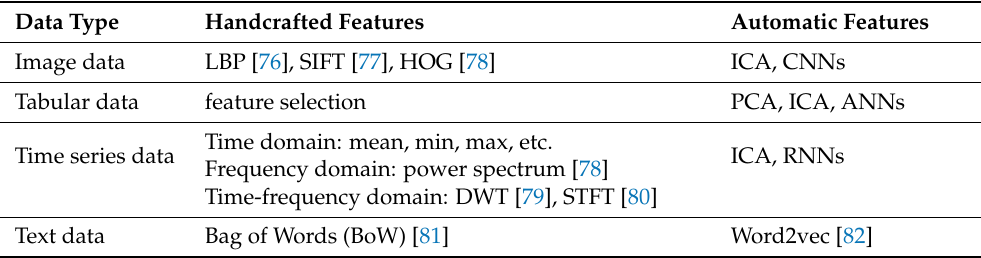
Table 3. Typical features for different data